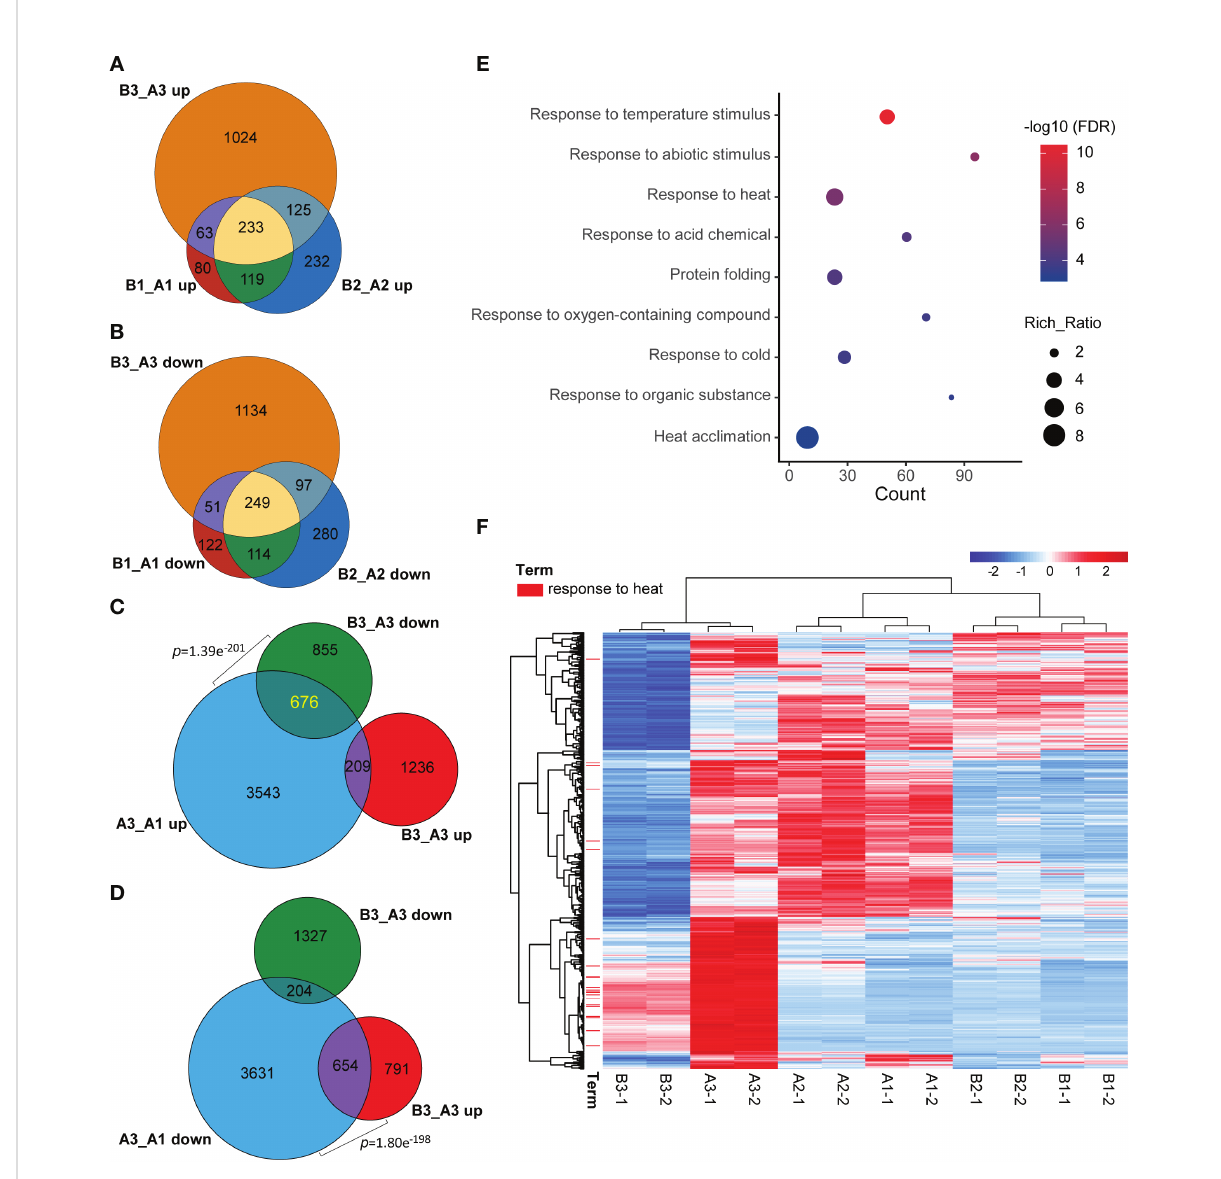
FIGURE 5 NTR1 promotes HSR gene transcription under heat stress. (A, B) Venn diagrams of common genes between upregulated (A) and downregulated (B) DEGs in hl761 vs. CK for different times of heat treatment. CK, background line for hl761. (C) Venn diagram showing the signi fi cant overlap between heat stress-induced and downregulated DEGs in hl761 vs. CK upon 38°C 60-min treatment. (D) Venn diagram showing the signi fi cant overlap between heat stress-repressed and upregulated DEGs in hl761 vs. CK upon 38°C 60-min treatment. p-Values (Fisher ’ s exact test) for overlapping between gene sets are labeled. (E) Gene Ontology (GO) annotation analysis for the biological function of the 676 common genes shown in (C). (F) Expression heatmap of the 676 common genes shown in (C) The heatmap shows the Z-score value of the FPKM of each gene. HSR, heat stress response; DEGs, differentially expressed genes; FPKM, fragments per kilobase of exon per million mapped